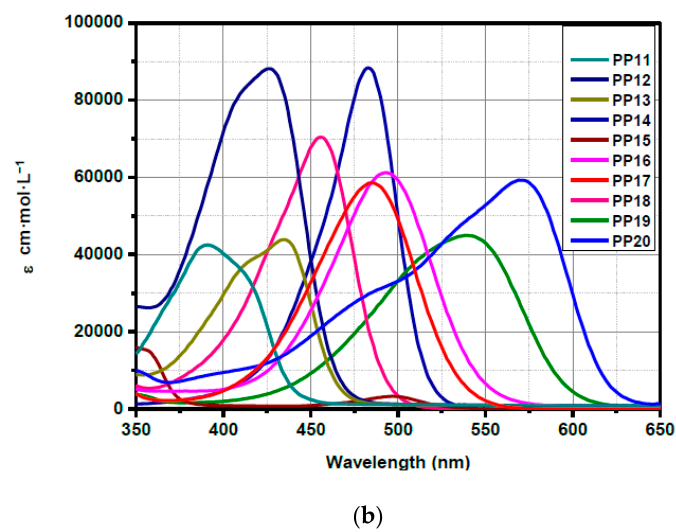
Figure 8. UV-visible absorption spectra of PP1 – PP10 ( a ) and PP11 – PP20 ( b ) in chloroform. Table 3. Summary of the optical properties of PP1 – PP10 in twenty-three solvents and Kamlet and Taft parameters π *.